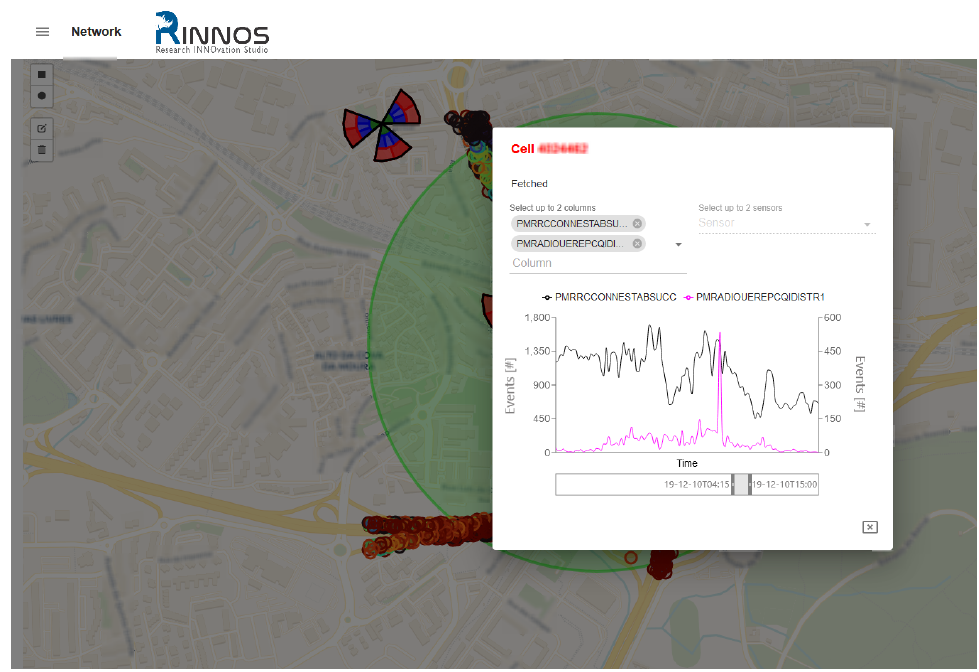
Figure 13. Visualization of cell KPIs centered at the failure